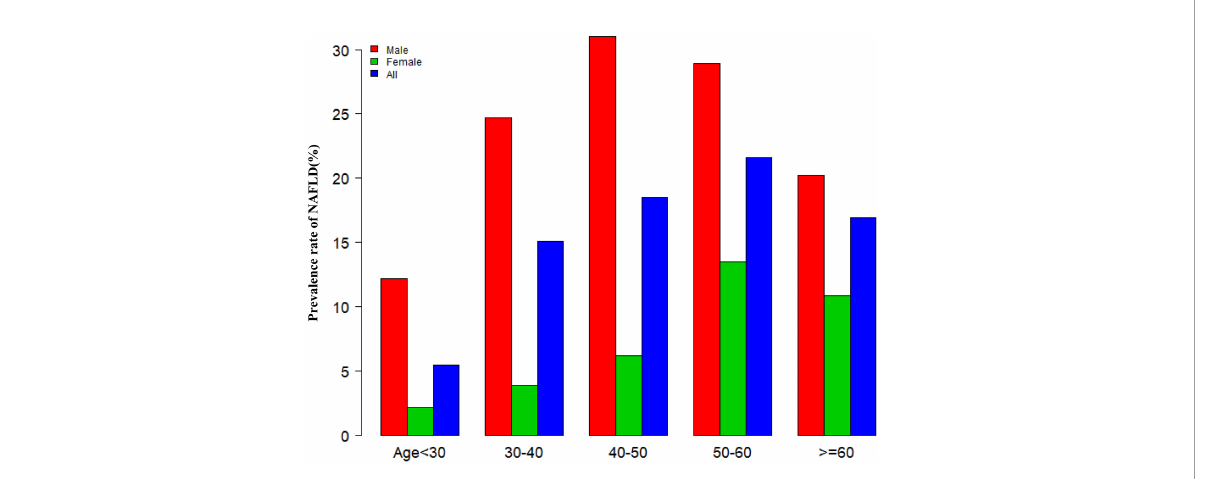
FIGURE 3 NAFLD prevalence of age strati fi cation by 10 intervals. Figure 3 showed that across the 10 age strati fi cations, male subjects had higher prevalence rates of NAFLD than female subjects, regardless of age group. It also found that the prevalence of NAFLD increased with age in both male(except age ≥ 50 years) and female(except age ≥ 60 years)